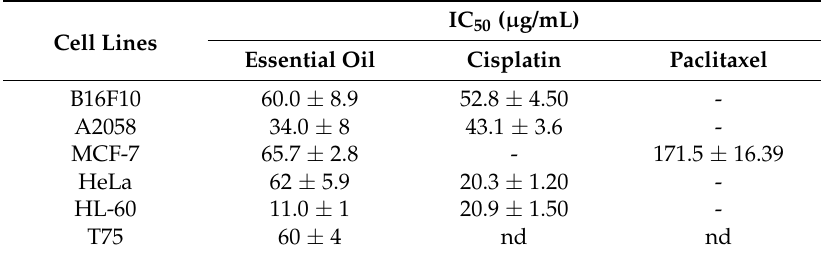
Table 3. IC 50 ( µ g/mL) values to essential oil from Z. monogynum leaves and to positive controls (cisplatin and paclitaxel) against tumor cell